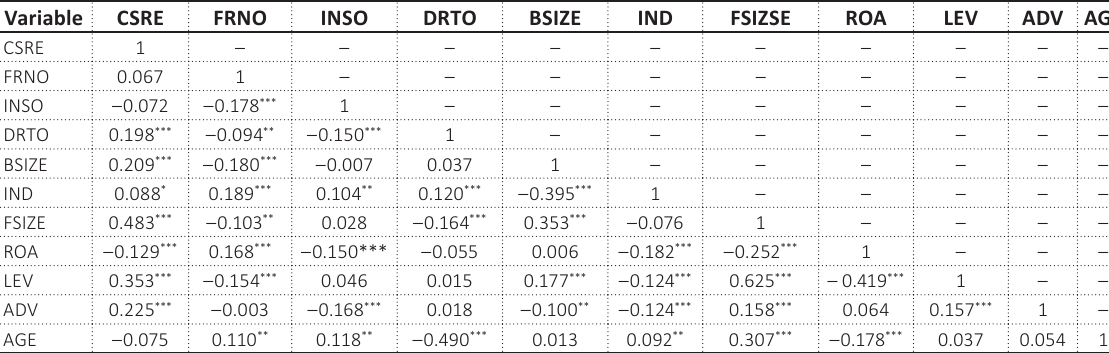
Table 4. Correlations matrix